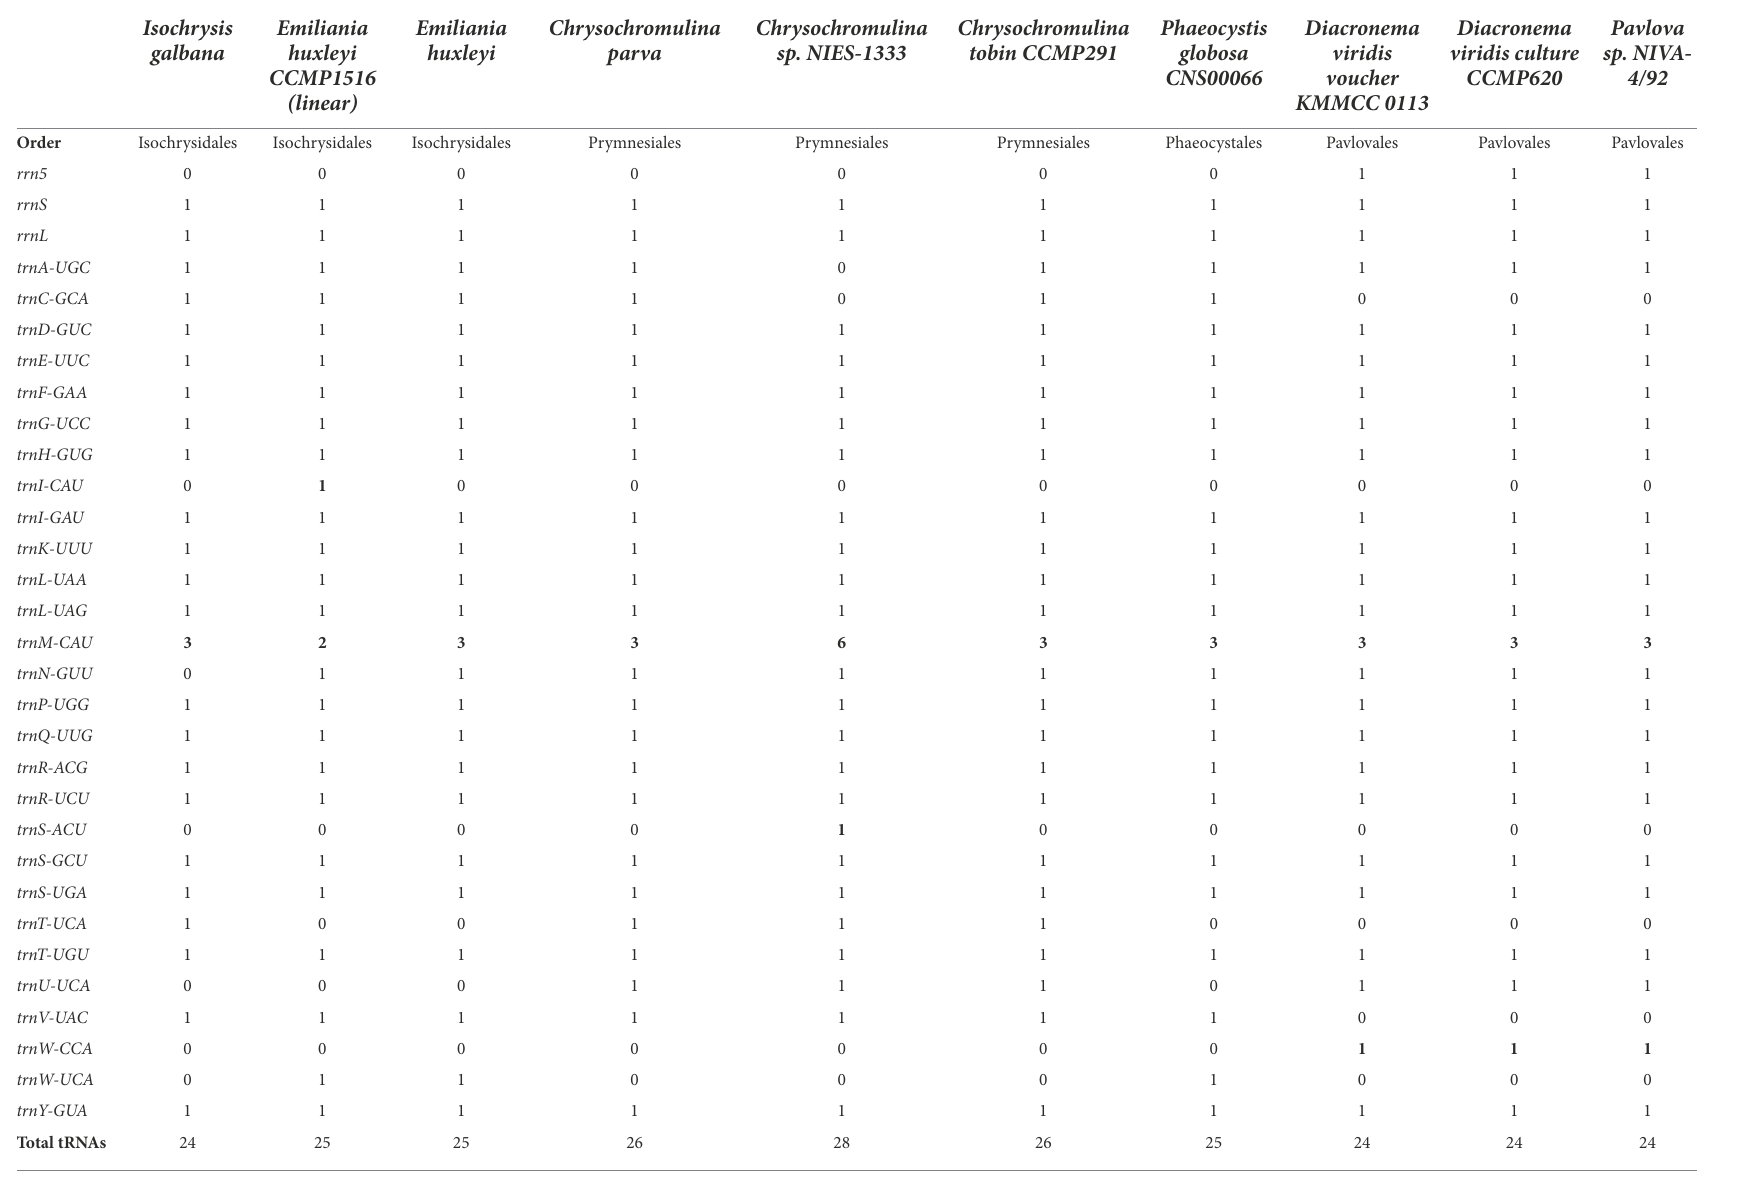
TABLE 2 Mitochondrial transfer RNAs (tRNAs) and rRNAs in